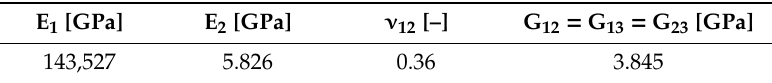
Table 1. Strength properties of the lamina.